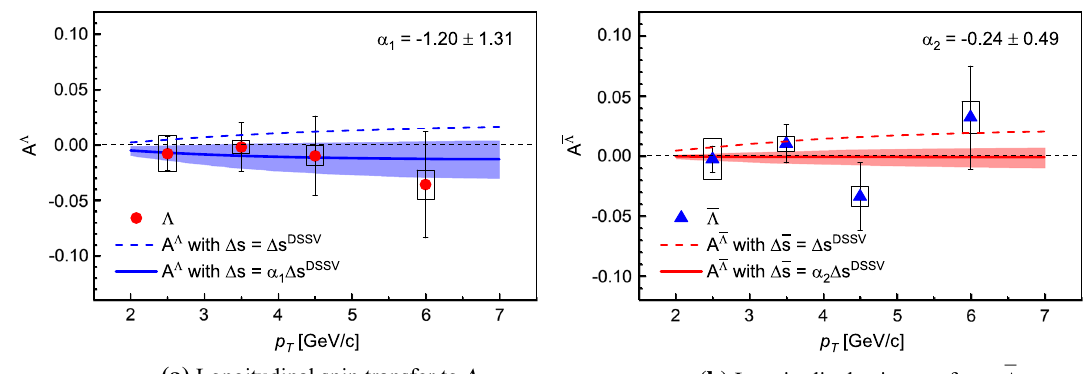
( a ) Longitudinal spin transfer to Λ . (b) Longitudinal spin transfer to ¯ Λ . Fig. 4 Comparison of the measured spin transfer data with theory pre- quarks, and the dashed curve, with cuts to a much smaller range in p T √ ¯ Λ compared to Fig. 3, represents the result with the symmetric input of the s = 200GeV.Markers dictionsA Λ andA forpositive η versus p T at polarized strange and antistrange quarks. The asymmetric coefficients with error bars are the data collected by the STAR Collaboration [55]. α The vertical bars and boxes indicate the sizes of the statistical and i for corresponding process are presented with errors. The shadow region covers the error band. More details about the fitting results of α i systematical uncertainties, respectively. The solid curve represents the are presented in Table 1 resultwiththeasymmetricinputofthepolarizedstrangeandantistrange Table 1 Fitting results of α i and calculated results of Δ s and Δ ¯